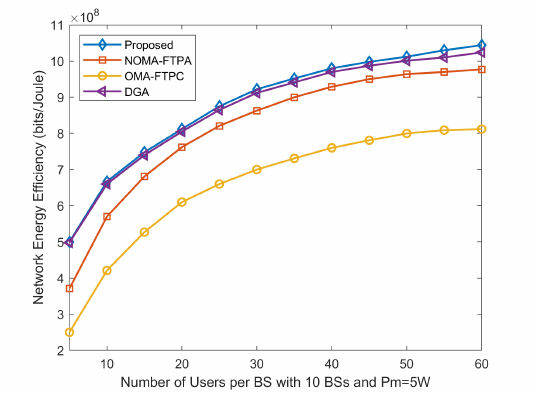
Figure 6. Network EE for different numbers of users per BS and P = 5